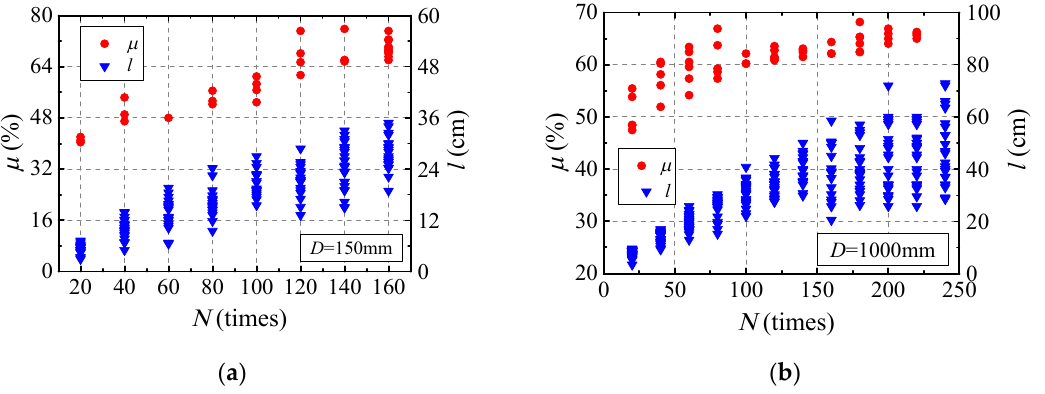
Figure 13. μ and l at different N : ( a ) D = 150 mm, and ( b ) D = 1000 mm.